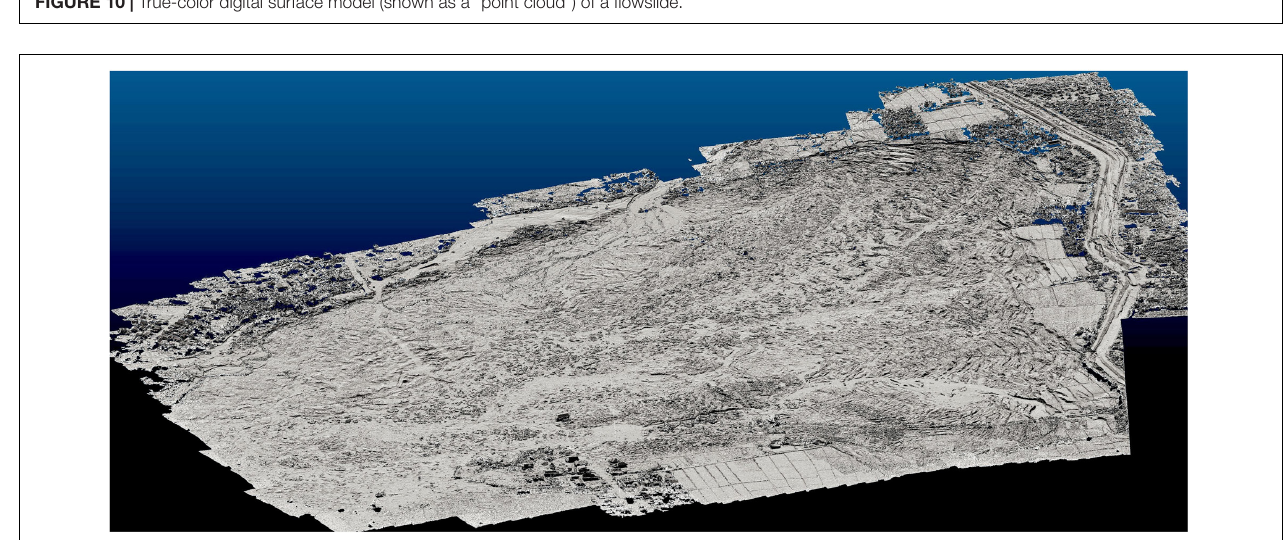
FIGURE 10 | True-color digital surface model (shown as a “point cloud”) of a flowslide.